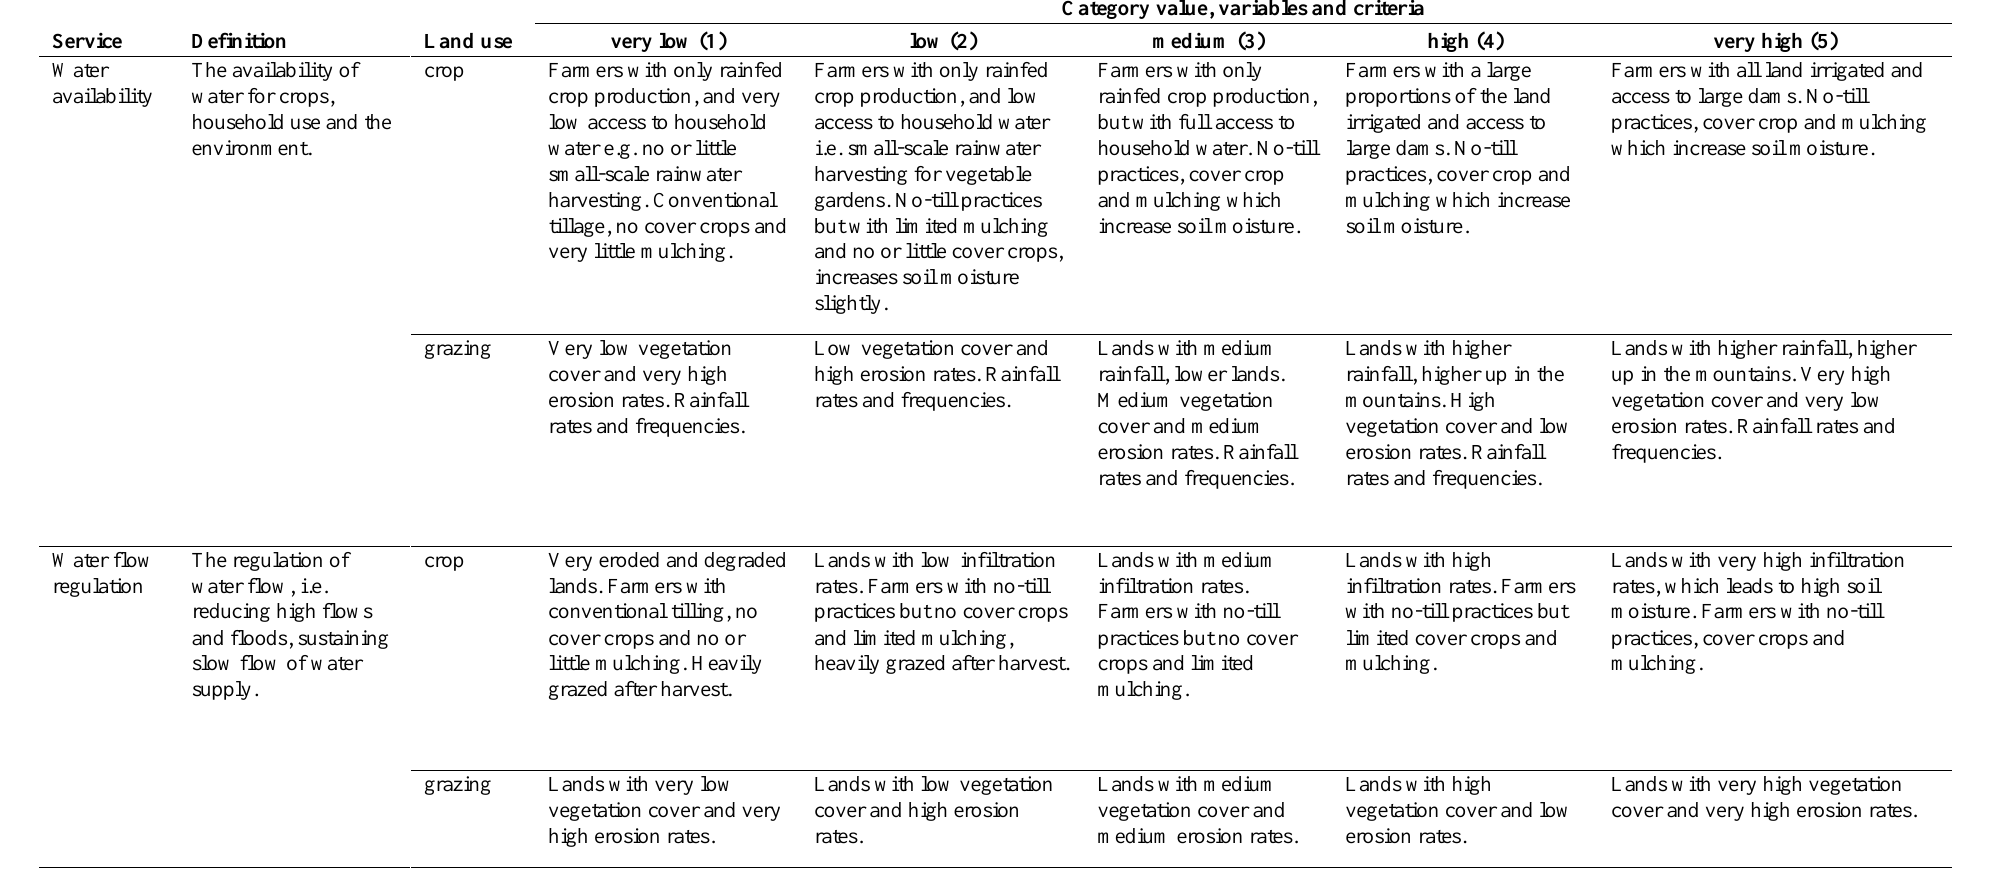
Table A1.2. Detailed description of category values, variables and criteria per land use for the expert assessment of the services water availability, water flow regulation, soil erosion regulation, and nutrient